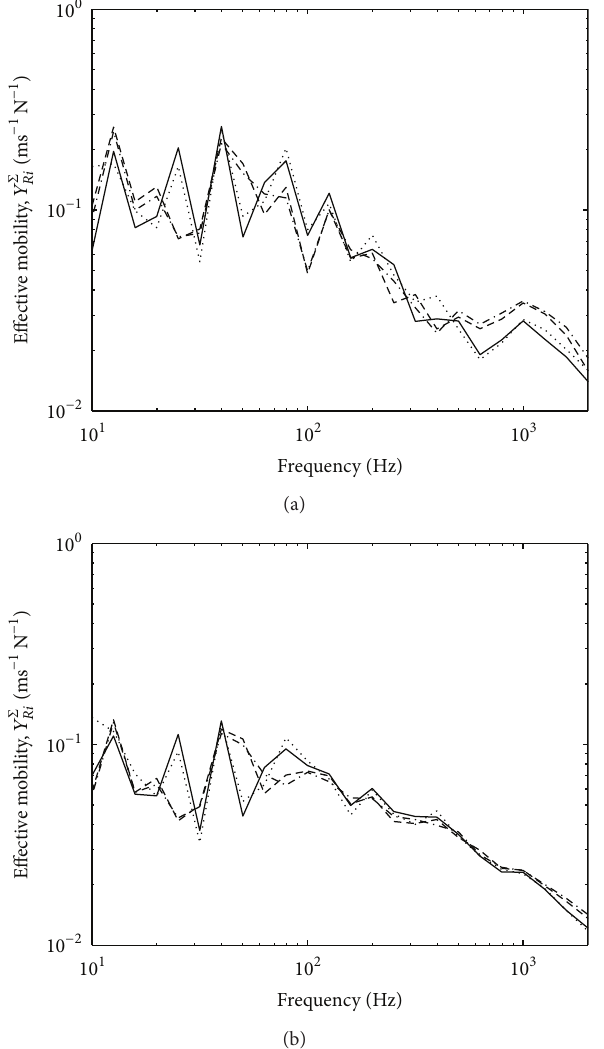
Figure 4: Effective mobility of the high mobility reception plate assuming: (a) zero phase and (b) random phase.